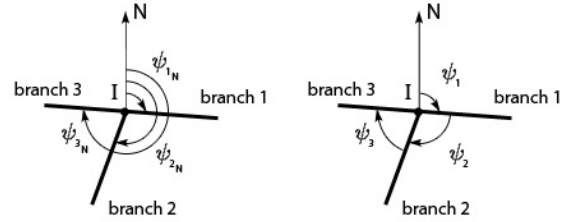
Figure 9: Road Intersection branch labelling and angle determi-